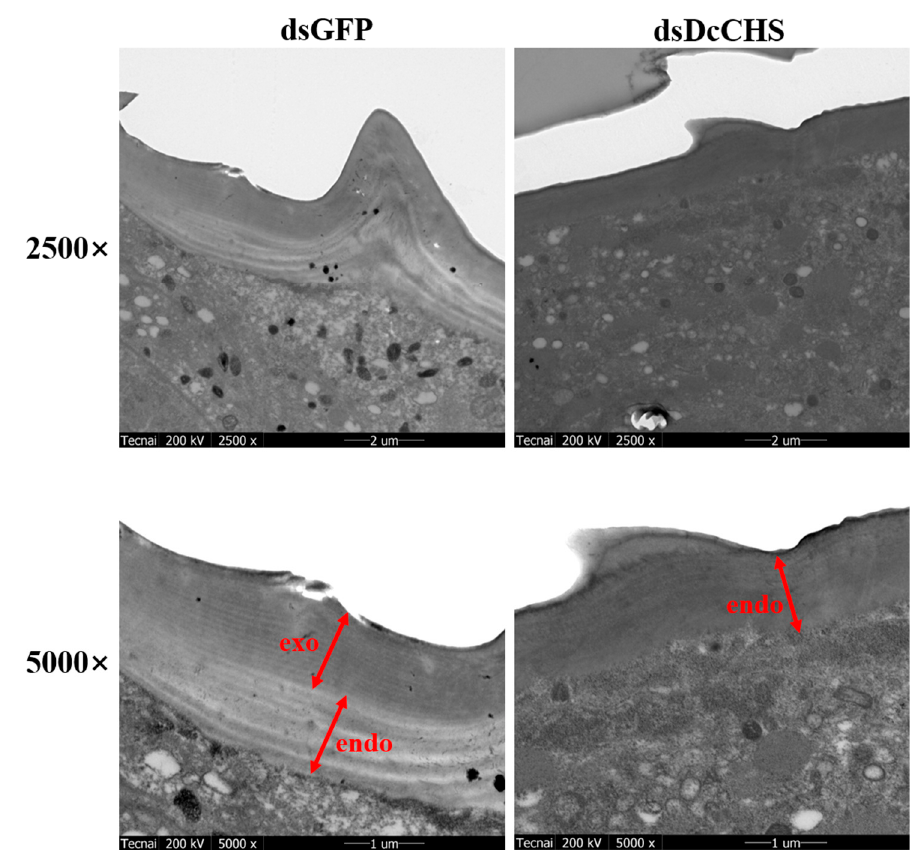
Figure 8. TEM observation of the integument of adult D. citri treated with ds DcCHS . D. citri treated with ds GFP as a control. Images were acquired using a Tecnai TEM. Three biological replicates were performed for each condition. (Endo: endocuticle; Exo: exocuticle).